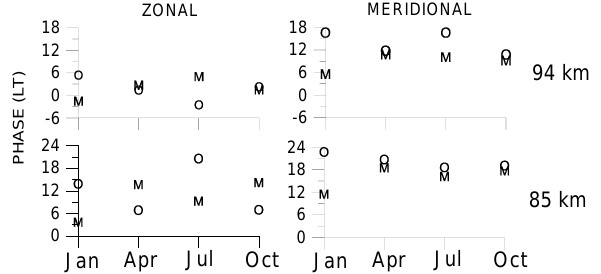
Fig. 8. Comparison between observed ( O ) and GSWM model ( M ) phases at Cariri at 82 and 94 km in January, April, July and October.